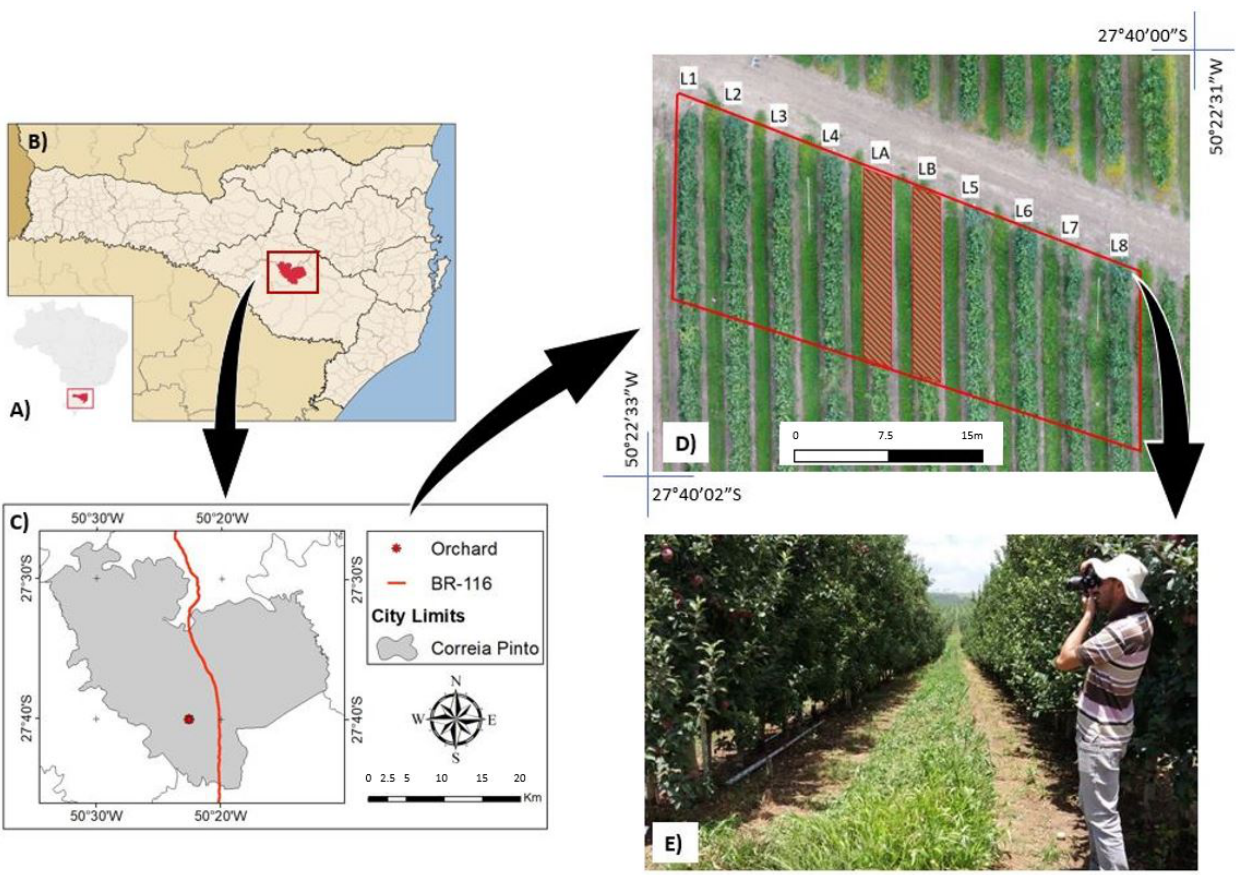
Figure 1. Study area within: ( A ) Brazil context; ( B ) Santa Catarina State context; ( C ) Municipality of Correia Pinto and location of the orchard [60]; ( D ) Aerial view of the sample site and Identification of the samples of the Fuji Suprema rows from L1 to L8, and Gala rows at LA and LB; ( E ) perspective of the Image acquisition in the orchard during the field survey.